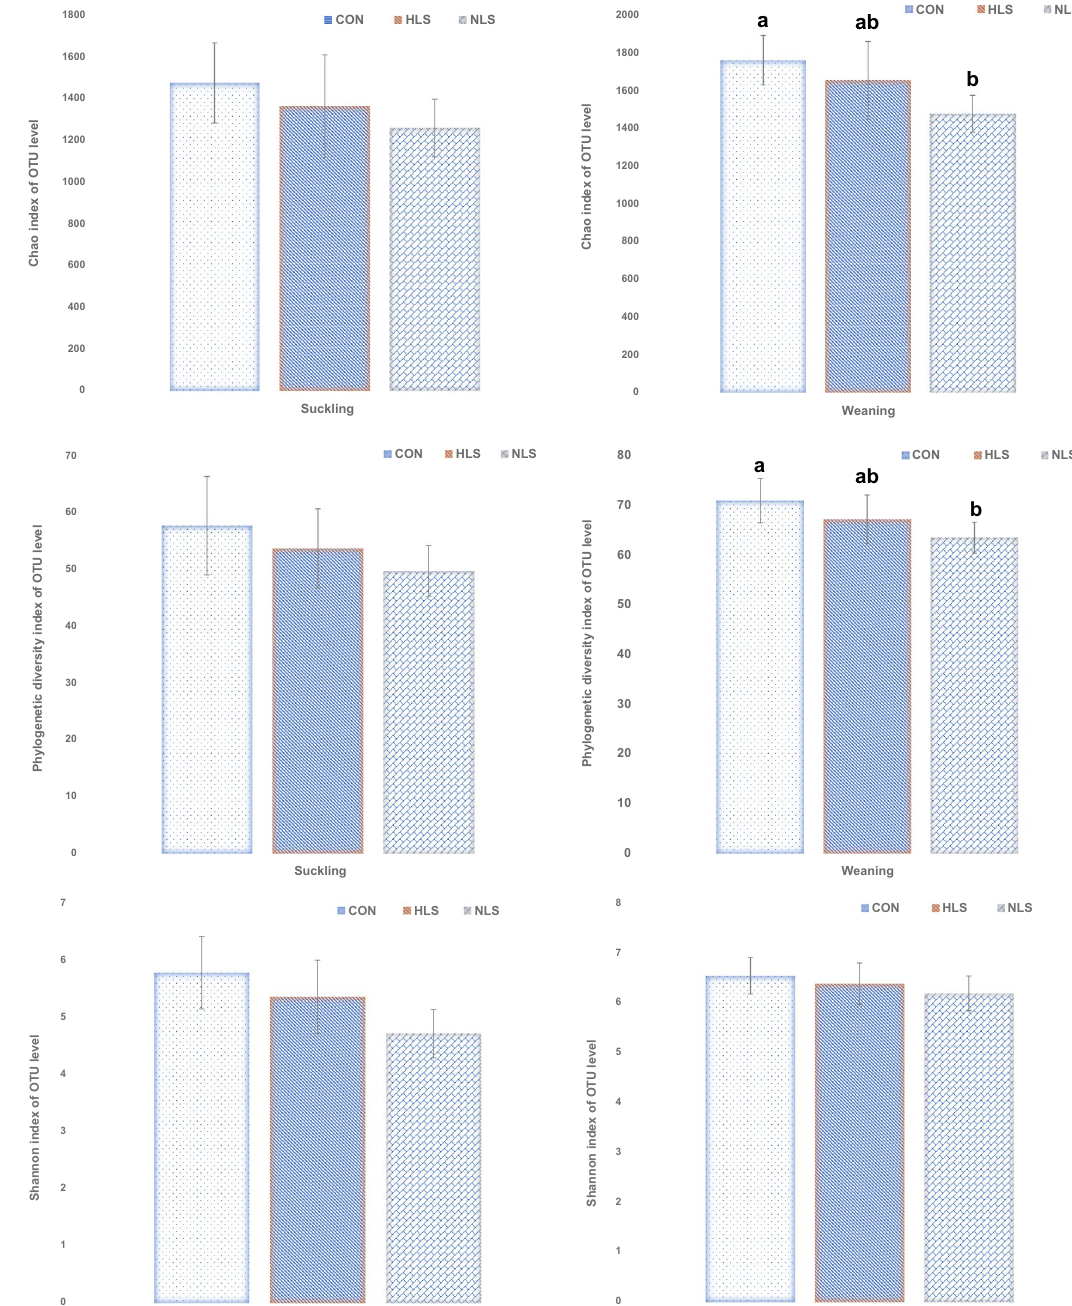
Figure 3. Differences in the fecal microbial species richness and diversity indices (Chao 1, Shannon, OTU; ≥ 97% sequence similarity threshold) per treatment. Different superscript letters indicate significant differences (P <